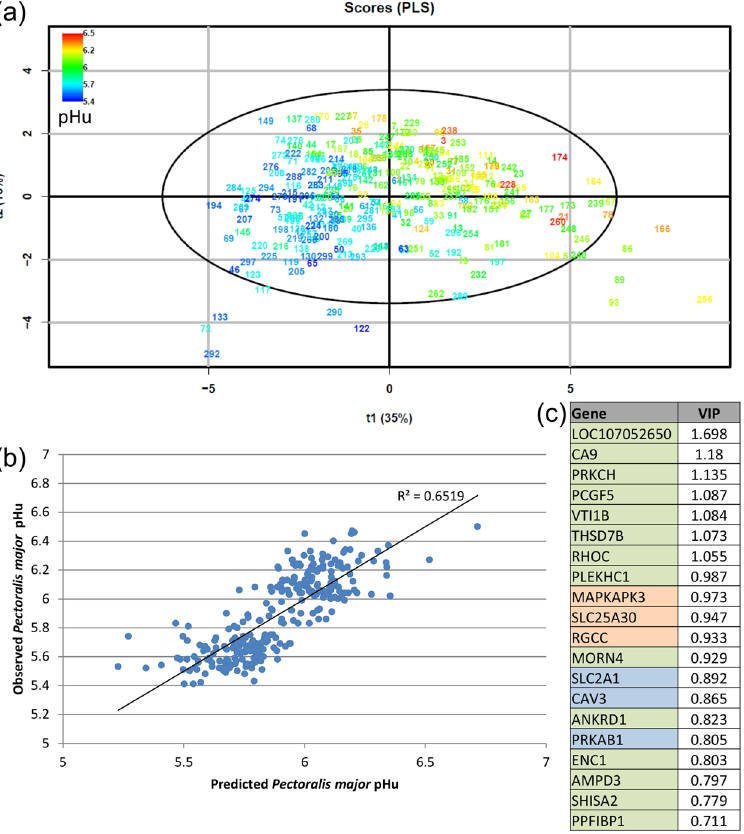
Figure 5. Final PLS model for the pectoralis major pHu prediction. The final PLS model was fitted on the mRNA expression of 20 genes (measured using RT-qPCR microfluidic technology) on a population of 278 male and female individuals from the pHu + and pHu − lines in order to predict the pectoralis major pHu. ( a ) Score plot of the two first components (t1, t2) from the PLS model. Points correspond to chicken tags coloured according to their measured pHu value in the pectoralis major muscle. The cumulative explanatory and predictive performance characteristics of the model are R 2 (cum) = 0.65 and Q 2 (cum) = 0.62. The root mean square error of the estimation (RMSEE) was 0.16. ( b ) Scatterplot of the observed pHu vs. predicted pHu. ( c ) Variable Importance in Projection (VIP) of each variable (genes) in the final PLS model (the genes from the fsPLS model are highlighted in green, those with an extreme FC based on microarray analysis are in orange, and those whose function is directly related to carbohydrate and muscle metabolism are in